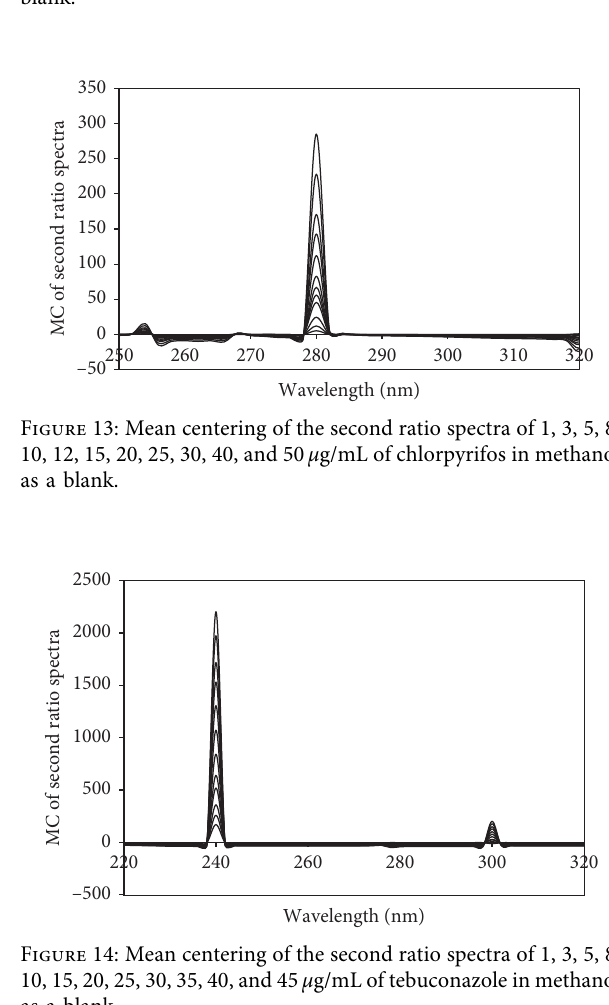
Figure 12: Mean centering of the second ratio spectra of 1, 3, 5, 8, 10, 12, 15, 18, 20, 25, and 30 μ g/mL of carboxin in methanol as a blank.